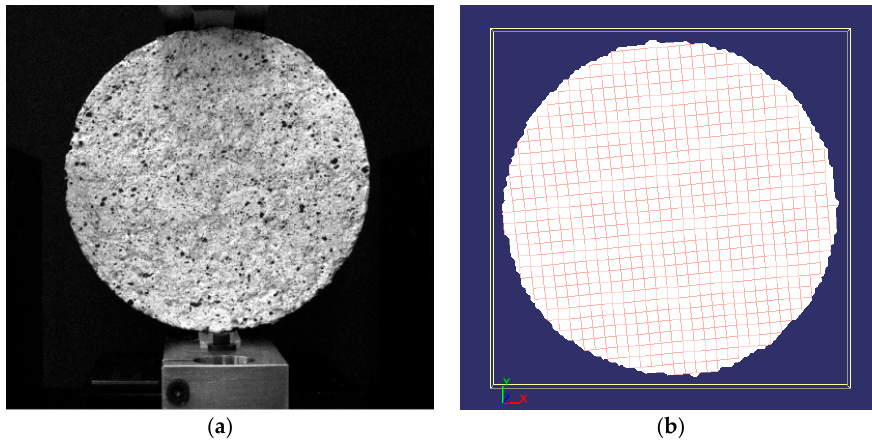
Figure 10. HMA sample: ( a ) View of the sample before testing; ( b ) virtual grid on the surface of the tested sample [25].